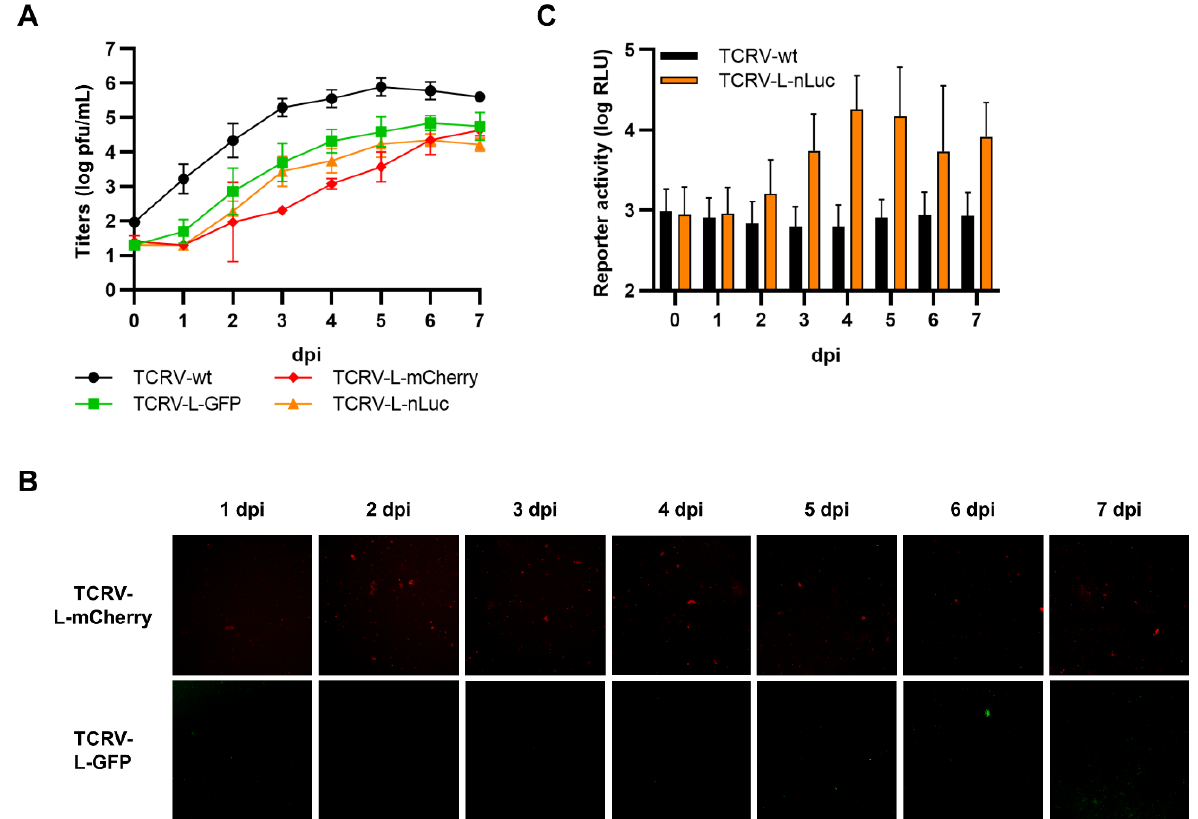
Figure 11. Recombinant viruses encoding internal fusions of TCRV L to reporter proteins. ( A ) Growth kinetics. Vero76 cells were infected at MOI = 0.005 with the indicated viruses. Supernatants were harvested on the indicated days and titrated by plaque assays in Vero76 cells. Results are shown as mean ± SD of three independent experiments. ( B ) Reporter activity (GFP/mCherry). Pictures of cells infected as in ( A ) were taken on the indicated days at 10× magnification. Results are shown as representative images from one experiment out of two independent experiments. ( C ) Reporter activity (nLuc). Cells infected as in ( A ) were lysed on the indicated days, and nLuc activity in lysates was measured. Results are shown as mean ± SD of four independent experiments.